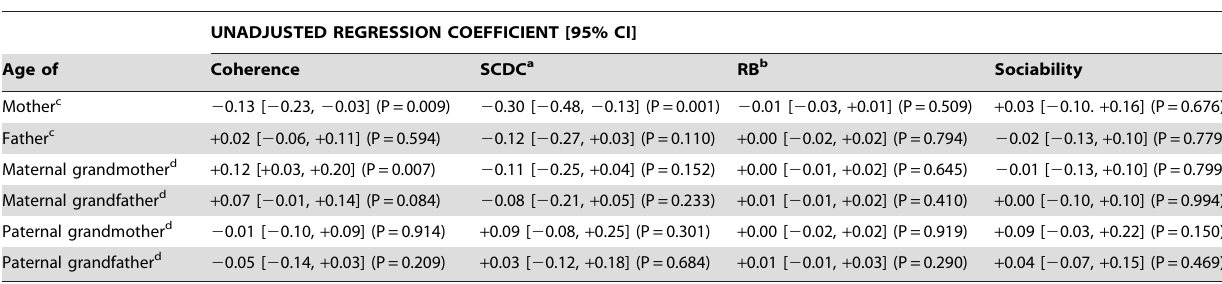
Table 4. Linear regression of parental and grandparental ages on autistic traits; results per 10 years increase in age, high scores indicate more autistic like traits adjusted for